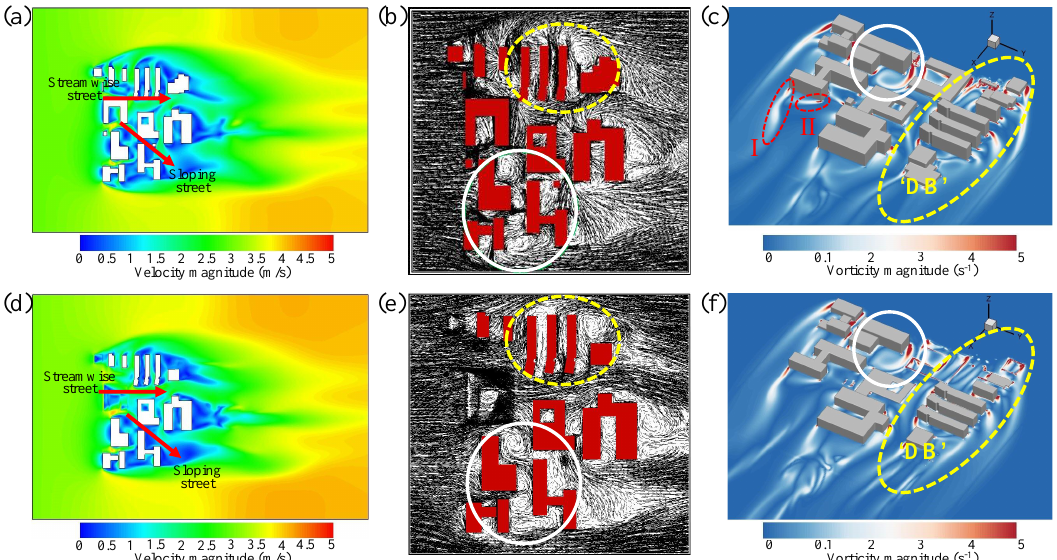
Figure 7. Flow distribution characteristics on horizontal planes of z = 2 m ( a – c ) and z = 10 m ( d – f ): ( a , d ) velocity contour; ( b , e ) velocity vector diagram; ( a , c ) vorticity contour.